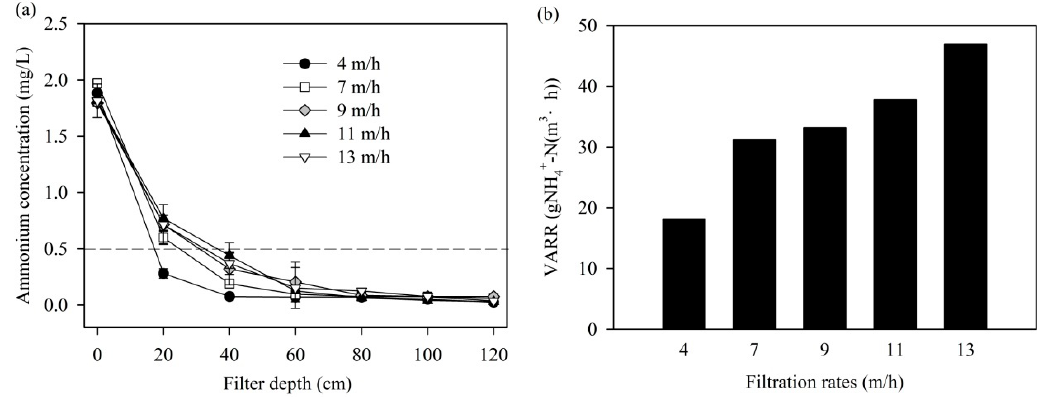
Figure 4. ( a ) Ammonium concentration depth profiles and ( b ) VARR at 0–40 cm filter depth at different filtration rates.